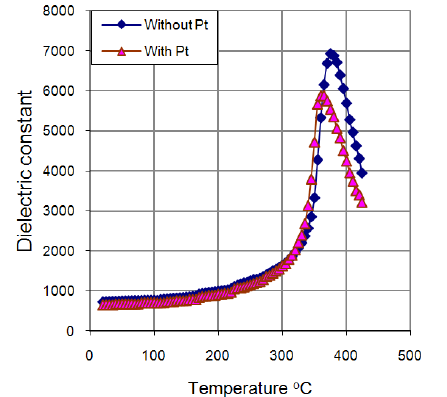
Figure 9. Dielectric constant of PLZT ceramic with and without